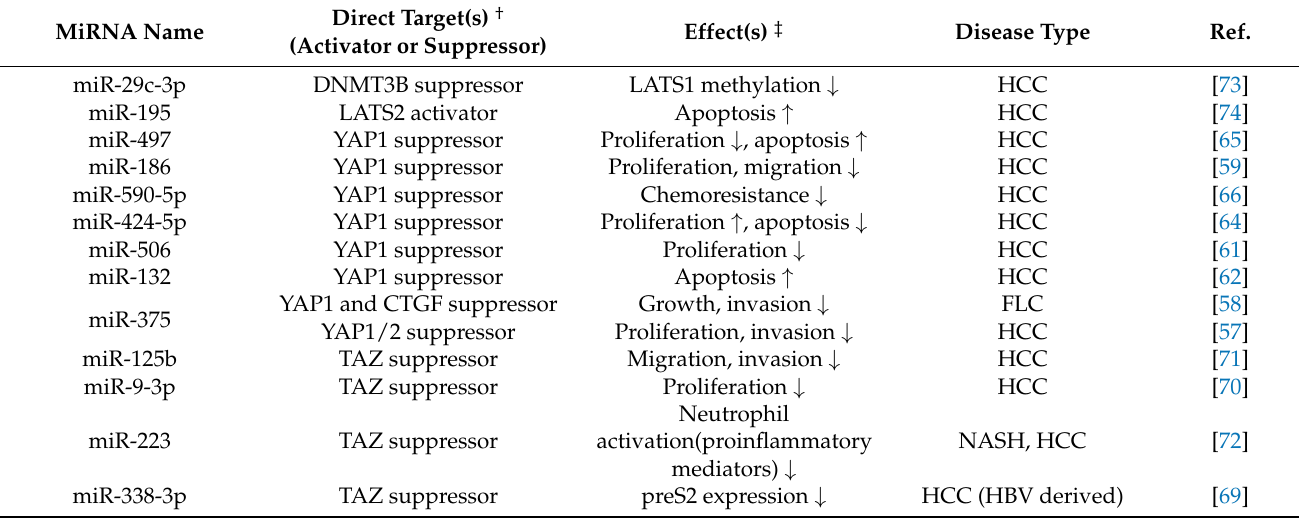
Table 1. List of tumor suppressive microRNAs inactivating YAP/TAZ and their effect(s) on liver